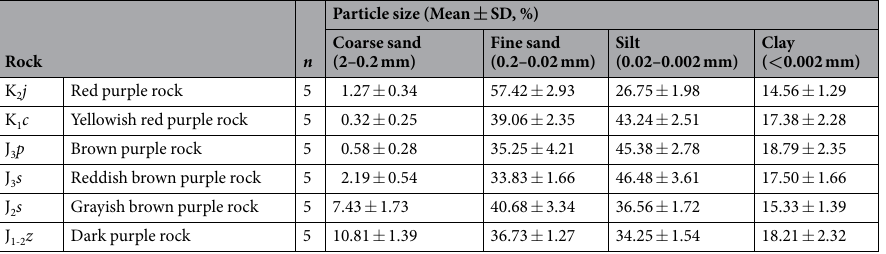
conditions, consist of a thick layer of purplish red mudstone and purplish red sandstone. The rocks are character- ized by a high porosity with many wide crevices. (4) The rocks of the Jurassic Suining Formation (J 3 s ), deposited and diagenetically altered in large shallow lakes under arid and hot conditions, are thick-bedded mudstones with thin- to medium-bedded silty sandstone and, are bright red or brownish red. The rocks are characterized by a low porosity and much narrow crevices. (5) The rocks of the Jurassic Shaximiao Formation (J 2 s ), deposited and diagenetically altered on a river floodplain or in a near-shore environment in a shallow lake under relatively humid conditions, are composed of grayish yellow to grayish white mudstone interbedded with thick-bedded sandstone that is grayish purple, gray, purplish gray, grayish purple or yellow in color. These rocks are character- ized by a high porosity. (6) The rocks of the Jurassic Ziliujing Formation (J 1-2 z ) were deposited and diagenetically altered in lakes or rivers under mild humid conditions. The lithofacies of these rocks are somewhat complex: the upper portion is composed of grayish green or dark purplish red mudstone; the middle is composed of thin- to medium-bedded gray carbonate rock, muddy carbonate rock mingled with purplish red or grayish purple mudstones; and the lower portion is composed of purplish red mudstones mixed with thin- to medium-bedded yellowish green silty sandstone or fine-grained quartz sandstones. These rocks are characterized by a low porosity and very fine crevices. Therefore, to the variability of paleoenvironment, the diagenetic environment determined the lithology of the purple rocks. Particle size distribution of the rocks. Purple rock particle size distribution depends greatly on the rocks’ diagenetic environment (Table 1). The sand contents of the purple rocks range between 35.83% and 58.69%, and tend to be higher in the red purple rocks (58.69%) of the Cretaceous Jiaguan Formation (K 2 j ), grayish brown purple rocks (48.11%) of the Jurassic Shaximiao Formation (J 2 s ) and dark purple soils (47.54%) of the Jurassic Ziliujing Formation (J 1-2 z ) and lower in other purple rocks (35.83–39.38%). The coarse sand contents in the purple soils are less than 5.00% except in the dark purple rocks (10.81%) and grayish brown purple rocks (7.43%). Compared to the sand contents, the clay contents of the purple rocks exhibit the opposite pattern: the clay contents of the red purple rocks (14.56%) and grayish brown purple rocks (15.33%) are much lower than those of the other rocks (17.38–18.79%). Mineralogy and chemical composition of rocks’ clay fractions. To determine geochemical inheritance of purple soils, the mineralogy and chemical composition of the rocks’ clay fractions were obtained from the C horizon or BC horizon of representative soil profiles (Fig. 4). The clay-sized fraction in the purple rocks is generally domi- nated by illite (2 θ at 8.84°, 17.73°, 26.76°), vermiculite (2 θ at 6.14°, 31.84°), chlorite (2 θ at 6.22°, 12.38°, 25.01°), and montmorillonite (2 θ at 5.70°~5.85°), with little quartz (2 θ at 20.90°, 26.65°) and with or without kaolinite (2 θ at 12.38°, 24.93°) (Fig. 5). The SiO 2 /Al 2 O 3 , SiO 2 /Fe 2 O 3 and SiO 2 /R 2 O 3 ratios of the clay fraction in the purple rocks are shown in Table 2. The SiO dark purple rocks (4.00). The SiO 2 /Fe 2 O 3 and SiO 2 /R 2 O 3 ratios of the clay fraction in the purple rocks range from 12.59 to 18.20 and from 2.81 to 3.70, respectively. The CEC in the purple rocks varies from 15.25 cmol c kg − 1 to 20.39 cmol c kg − 1 , and the exchangeable cations in the purple rocks are regarded as a direct source of soil nutrients. Calcium carbonate content and pH value of the rocks. The calcium carbonates in the purple rocks in the Sichuan Basin mainly originates from the diagenetic environment (Table 3). The carbonate contents of the brown purple rock and reddish brown purple rock are high, with the values of 6.35% and 6.87%, respectively, and the associ- ated pH values are approximately 8.1 and 8.2, respectively. The carbonate content of yellowish red purple rock is slightly lower than the above two purple rocks, with a value of 5.68%, and the associated pH value is approxi- mately 7.9. The calcium carbonate contents of the grayish brown purple rock and dark purple rock are 1.29% and 1.03% respectively, and the associated pH values are about 7.2 and 7.3, respectively. The calcium carbonate is not present in the red purple rock, and the associated pH value is approximately 5.8. The large differences in calcium carbonate contents and pH values among the purple rocks result from the material sources and diagenetic envi- ronment of purple rocks. Organic matter and nutrient contents of the rocks. The OM and nutrient contents of the purple rocks are shown in Table 4. The OM contents of the purple rocks vary from 2.1 g kg − 1 to 3.6 g kg − 1 . The OM contents of the yellow- ish red purple rock, grayish brown purple rock and dark purple rock are higher than 3.0 g kg − 1 . The OM contents of the red purple rock and brown purple rock are less than the three purple rocks above, with values of approxi- mately 2.7 g kg − 1 and 2.4 g kg − 1 , respectively. The OM content of the reddish brown purple rock is the lowest, with